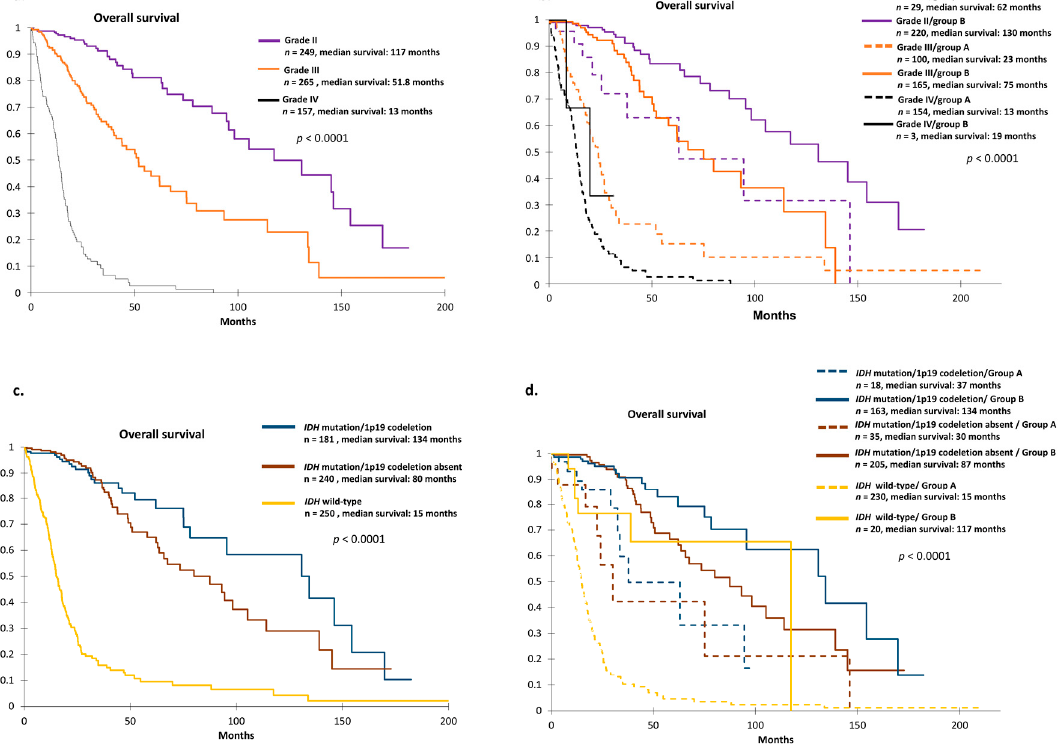
Figure 3. ( a ) Overall survival curves according to grade in TCGA cohort by Kaplan–Meier analysis. p -values were calculated using log-rank test. ( b ) Overall survival curves according to grade and 26-gene signature in TCGA cohort. Survival group A (dotted line) defined unfavorable prognosis, and survival group B (solid line) defined favorable prognosis ( p < 0.0001) by Kaplan–Meier analysis. In subgroups for each grade, the 26-gene signature provided information about prognosis. p -values were calculated using log-rank test. ( c ) Kaplan–Meier overall survival curves according to molecular characteristics in TCGA cohort. p -values were calculated using log-rank test. ( d ) Overall survival curves according to molecular characteristics and 26-gene signature in TCGA cohort. Survival group A (dotted line) defined unfavorable prognosis, and survival group B (solid line) defined favorable prognosis ( p < 0.0001). In each subgroup of molecular characteristics, the 26-gene signature further refined prognosis. p -values were calculated using log-rank